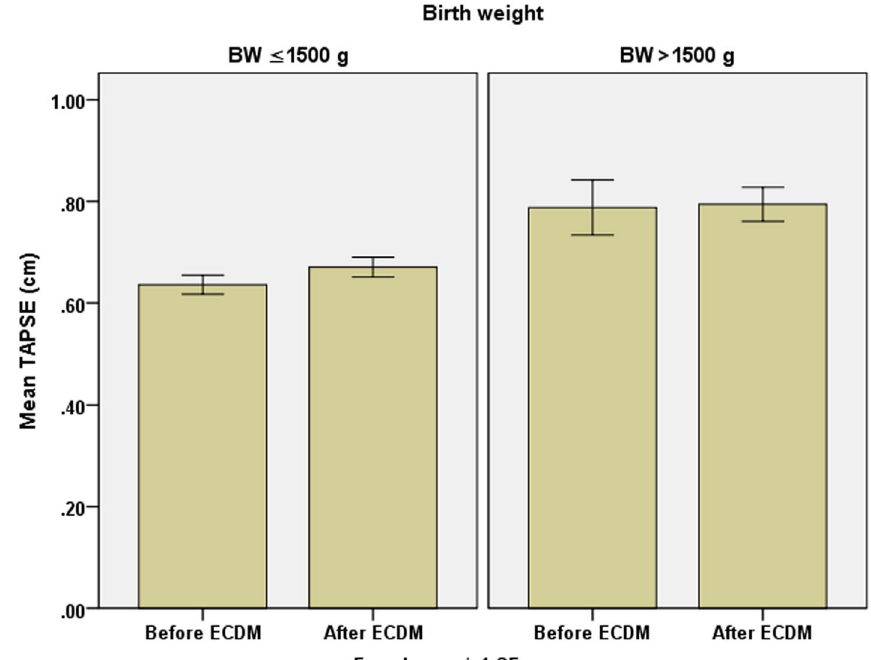
Fig. 3 Mean TAPSE before and after ECDM in patients with birth weight